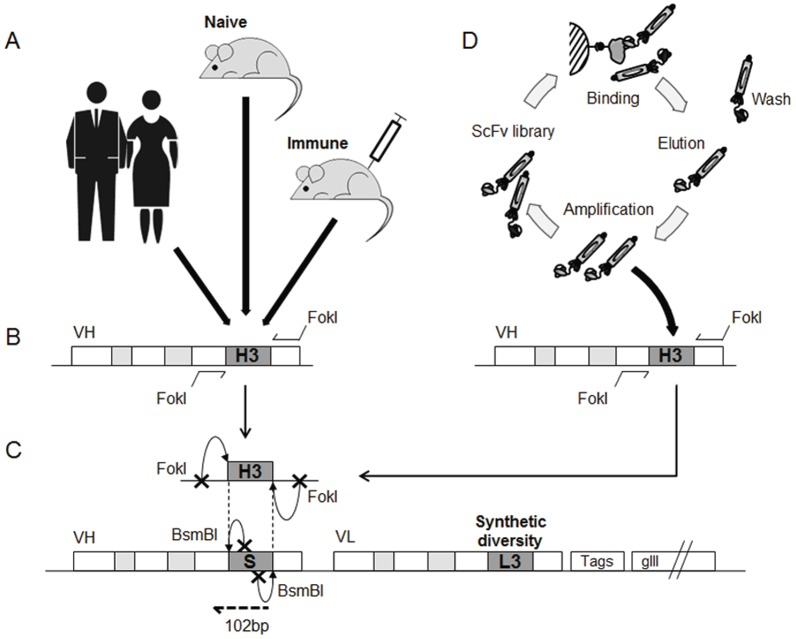
Strategy for capturing CDRH3 diversity into a human antibody library.(A) Natural diversity was incorporated from naive human donors and BalbC mice either kept naive or immunized with hIFNγ or hCCL5. (B) Their CDRH3 repertoires were extracted and amplified by PCR. During this step, recognition sites for the type IIS enzyme FokI were added. CDR3 are represented in dark grey, CDR1 and 2 in light grey. (C) Following digestion by FokI, repertoires of CDRH3 were cloned into an acceptor library itself digested with BsmBI. This second type IIS enzyme allowed the removal of a non diversified stuffer sequence (“S”) at the location of CDRH3 and the generation of compatible cohesive ends for the incorporation of CDRH3. The acceptor library combines 7 human VH and 7 human VL in a format of scFv as well as additional synthetic diversity in the CDRL3 (“L3” in the picture). Tags allow for purification while gIII allows for display on phage. After cloning of CDRH3, resulting libraries were analyzed by NGS covering the location of the CDRH3 and part of VH at the 5′ border (102 bp covered). (D) Similarly, sequences from a library of synthetic CDRH3, SnA, were explored in the context of the human acceptor library. Prior to the amplification, the repertoire of SnA was biased in vitro towards hIFNγ by performing three rounds of selection by phage display.